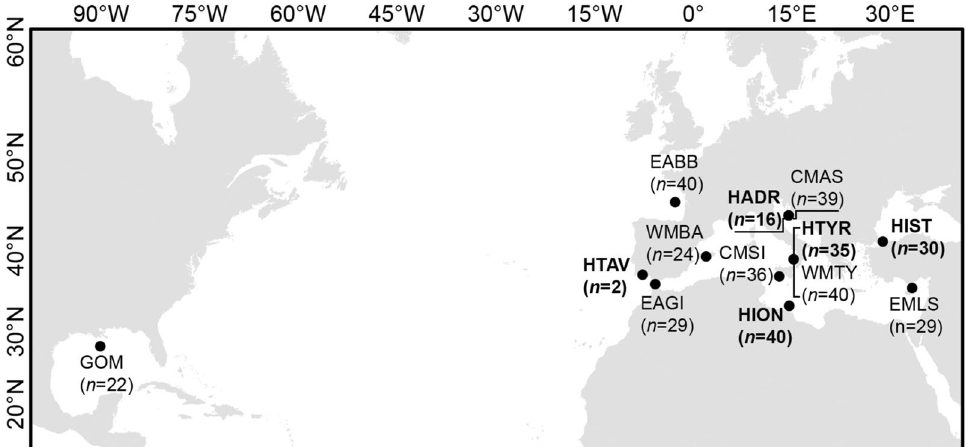
Figure 1. Map of the collection location for samples used in analyses. Historical (archival and archaeological) sample groups (in boldface, denoted with H) use approximate locations and the locations of archaeological sites where fish remains were recovered. Map created using ESRI ArcMap (v.10.6, https:// arcgis. com). Only sample groups that were successfully genotyped and analysed are displayed. Numbers ( n ) represent those included in the final analysis for each sample